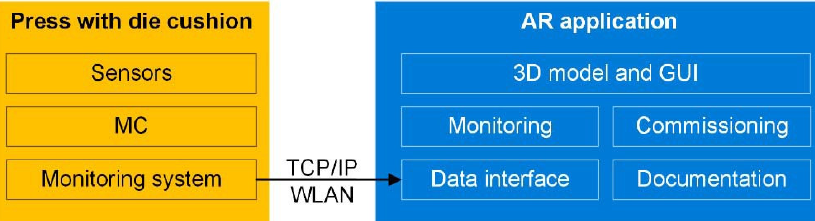
Figure 3. System structure for the Augmented Reality application and press systems.